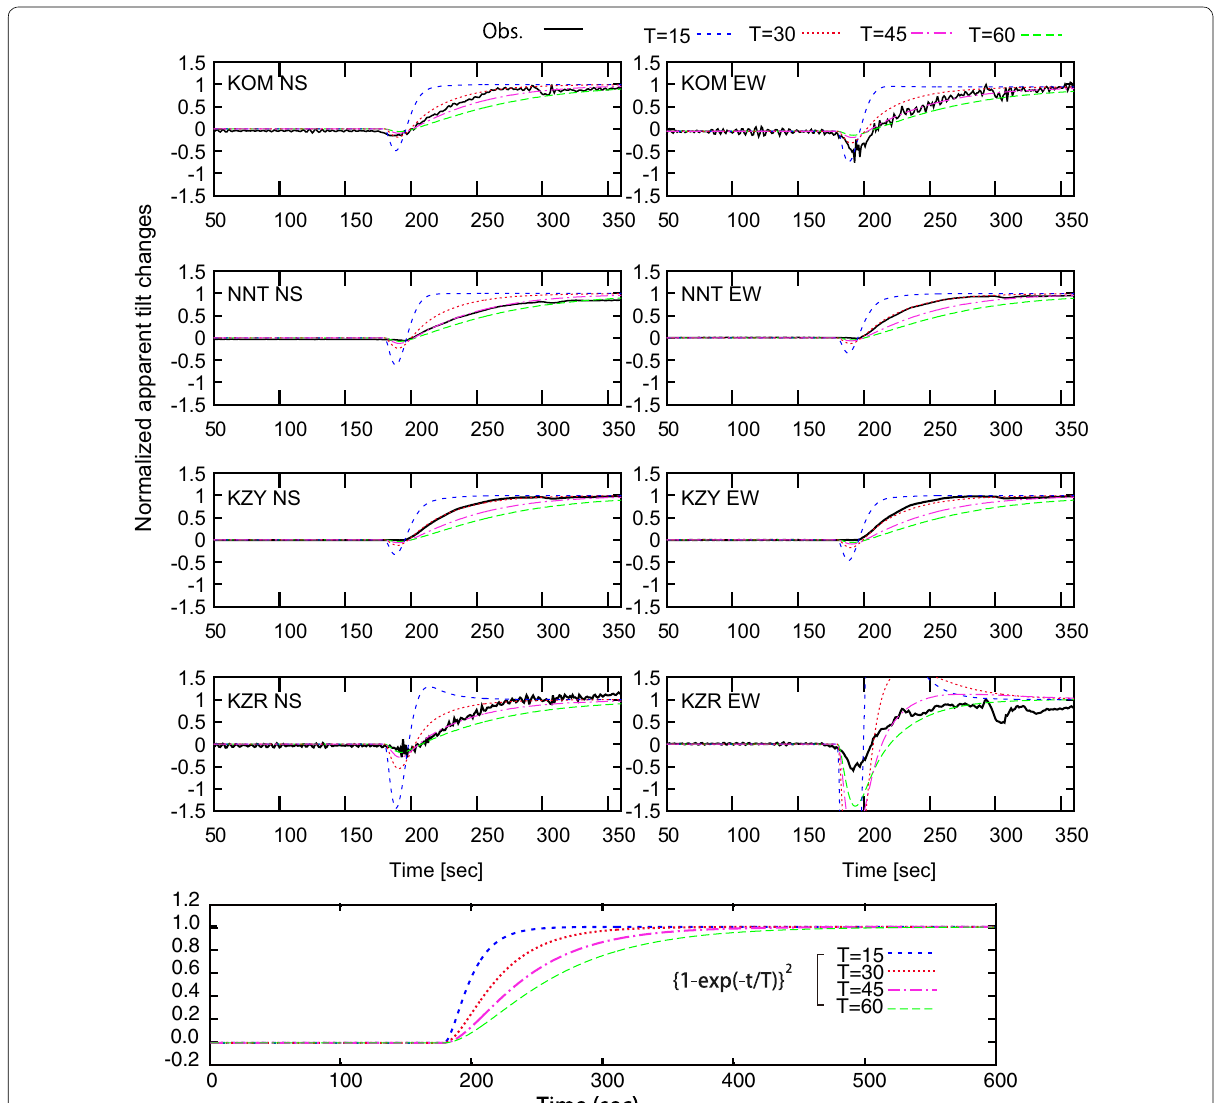
Fig. 8 Comparison of observed tilt records with theoretical apparent tilt records. The theoretical records were calculated using the best-fit model, as shown in Table 1. All tilt changes were converted to positive values regardless of their direction. The assumed time functions of source expansion, γ ( t ), are shown at the bottom of the